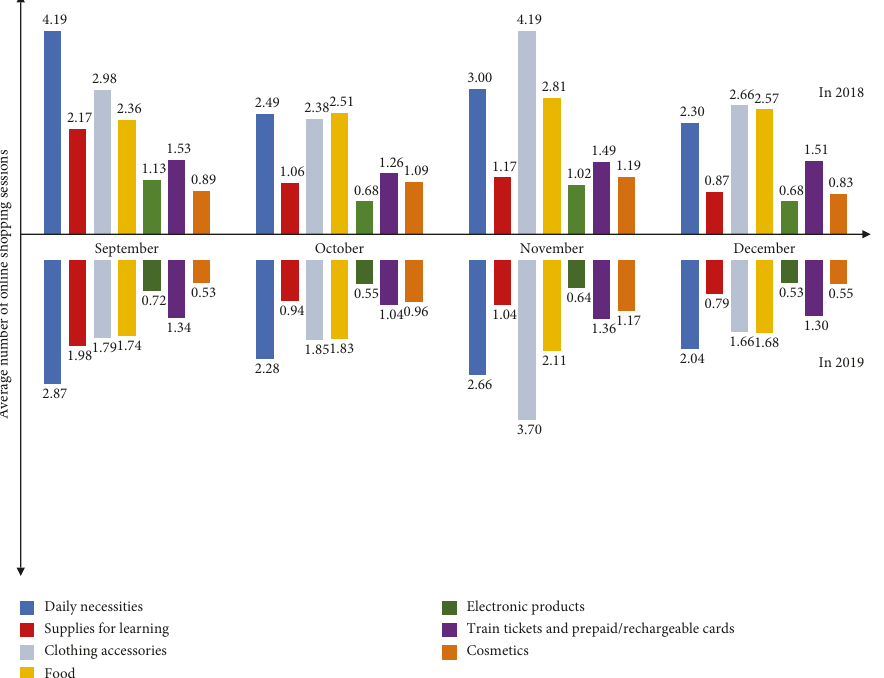
Figure 5: The various commodities purchased